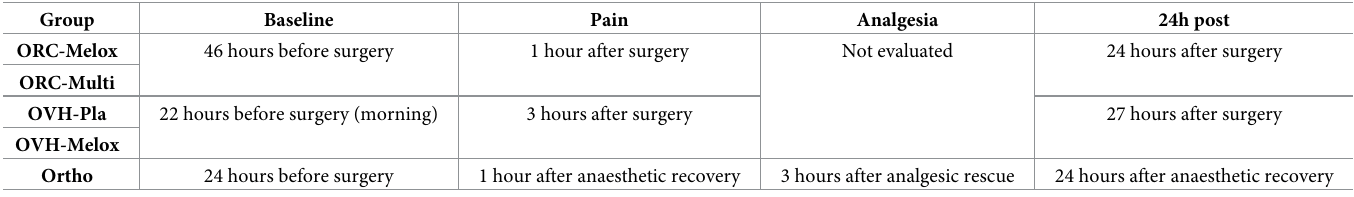
Table 2. Filming time points evaluated in the five groups of rabbits undergoing surgery.